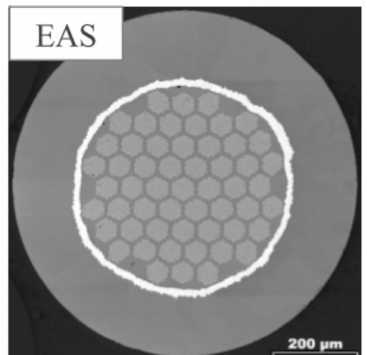
Figure 1. Cross section of the EAS-Nb 3 Sn superconducting strand